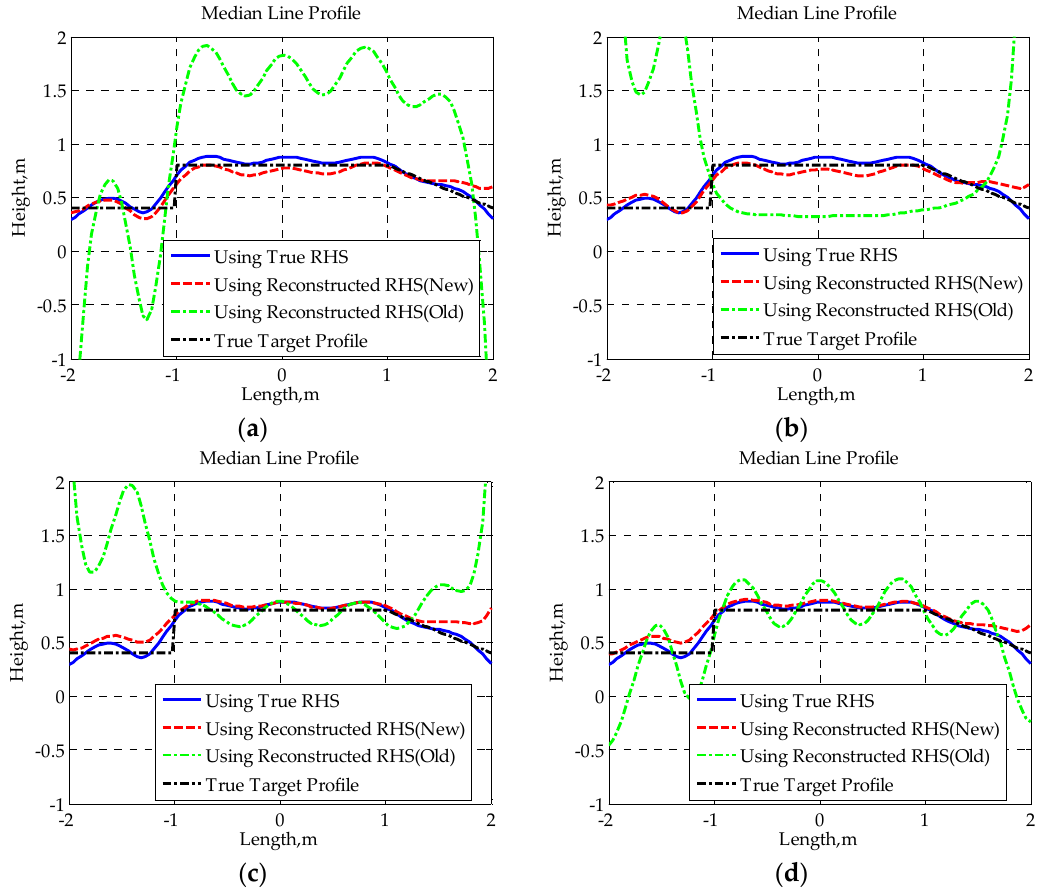
Figure 16. Median line profiles for baseline lengths: ( a ) 400 m; ( b ) 400.0375 m; ( c ) 400.075 m; ( d ) 400.15 m.